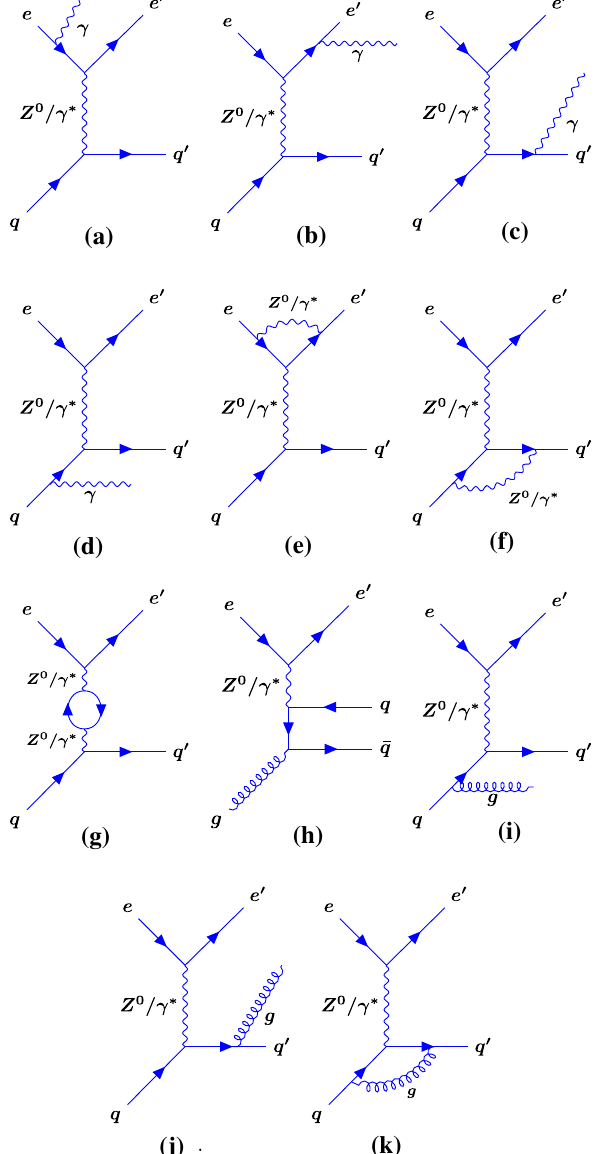
Fig. 2 Feynman diagrams for Deep Inelastic Scattering process with some leading order electroweak corrections ( a – g ) and QCD corrections ( h – k ). The proton remnant is omitted